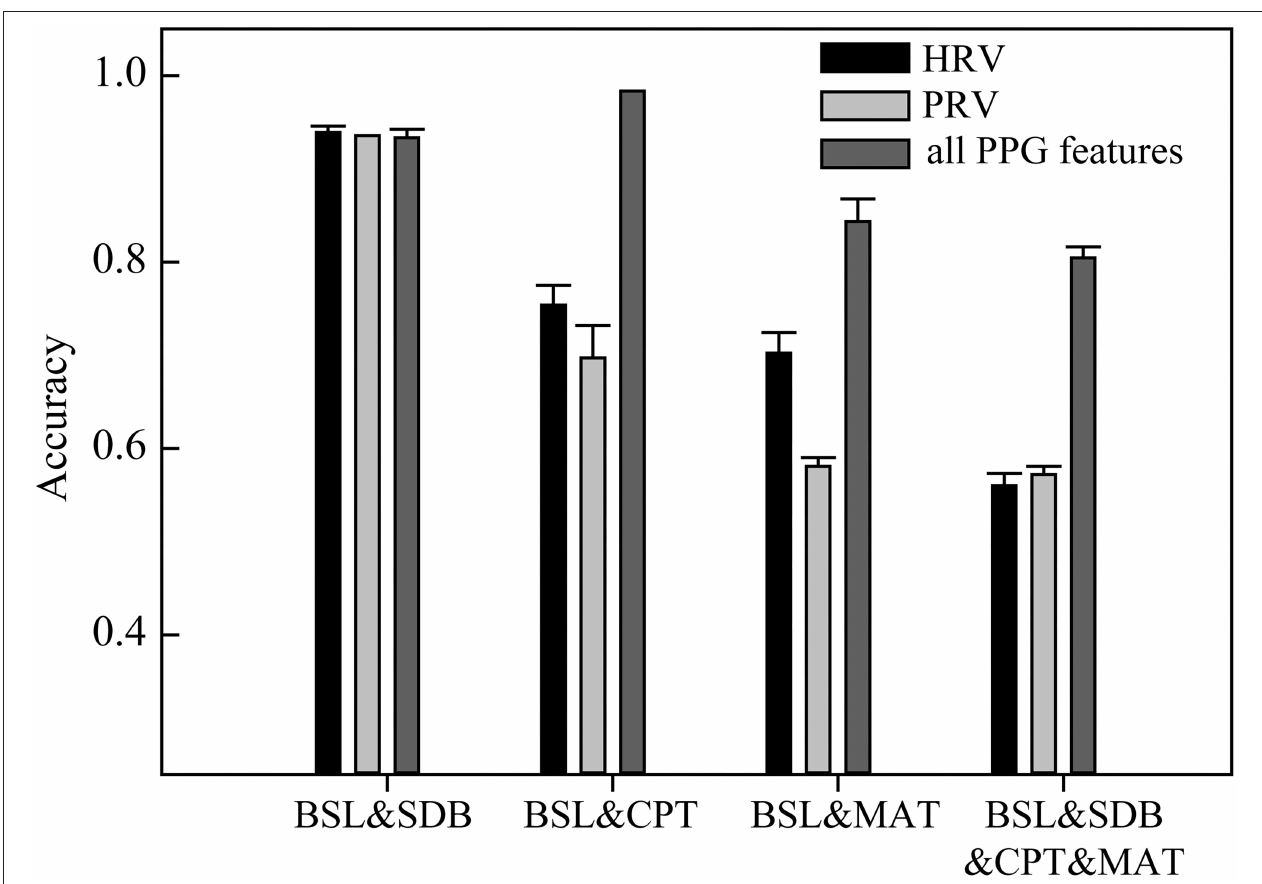
FIGURE 3 | The classification accuracies of the models based on heart rate variability (HRV), pulse rate variability (PRV), and all PPG-based features (mean accuracy of 30 runs at different random states).